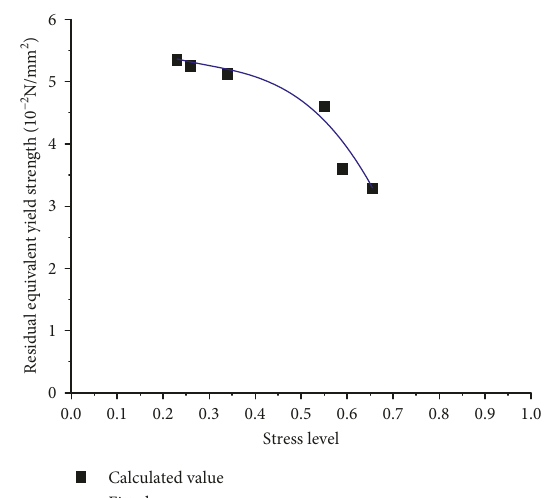
Figure 12: Calculated σ y and fitted values from ECC’s J R